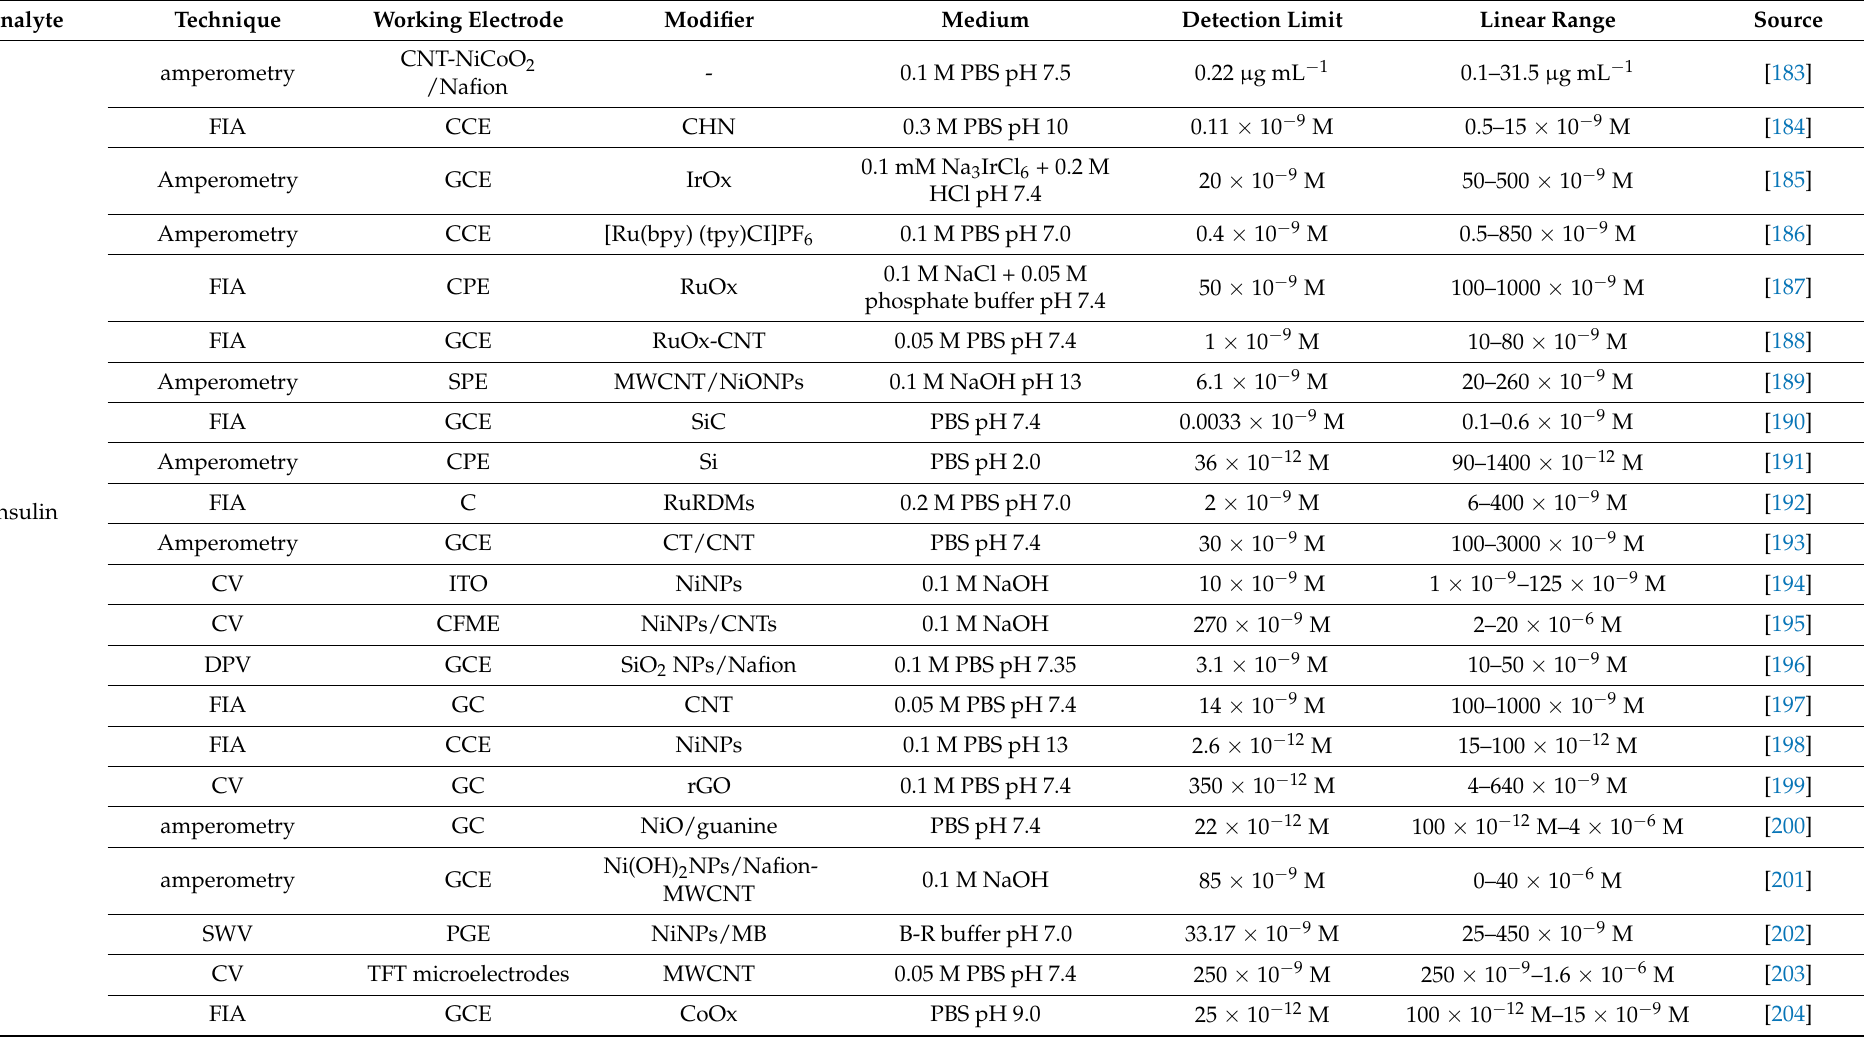
Table 3. Electrochemical methods of pancreatic hormones